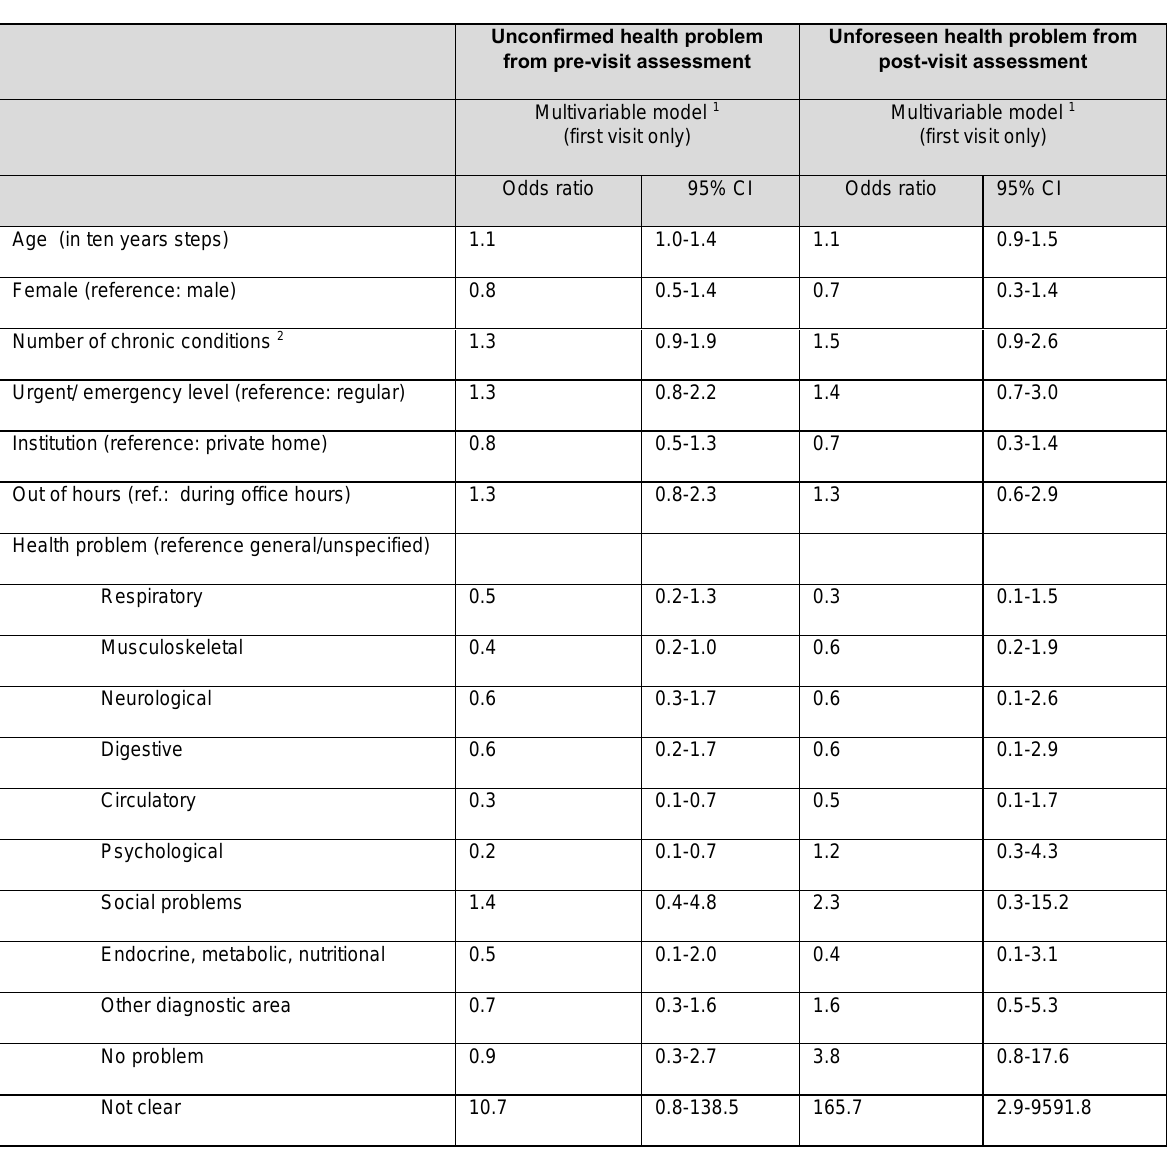
Table S2: Asso ciations of possible red flags w ith unconfirmed and unforeseen health problems, restricted to first visits